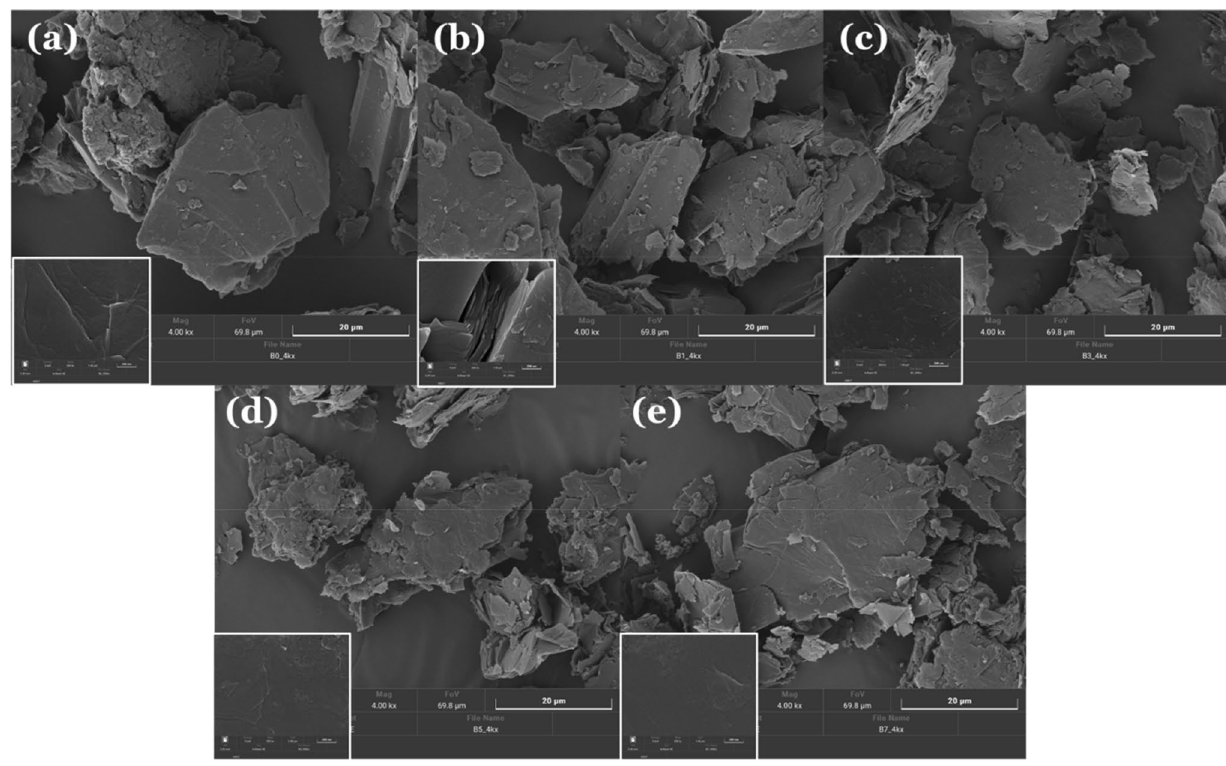
Fig. 2 SEM image of 4203-BX-2500 (× 2000 magnification): a 4203-B0-2500, b 4203-B1-2500, c 4203-B3-2500, d 4203-B5-2500, e 4203-B7- 2500. (The inserted image (bottom left) was measured at × 20,000